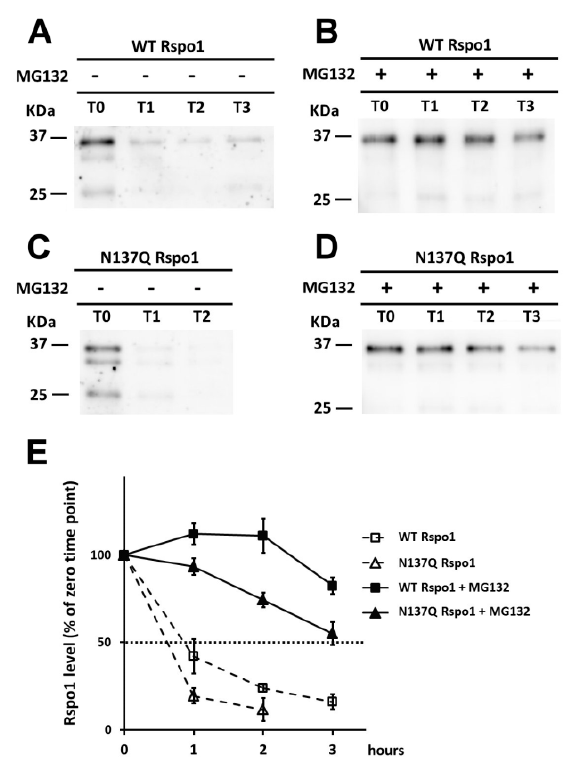
Figure 8. Effect of N-glycan on the stability of intracellular Rspo1. ( A – D ) HEK293T cells were transfected either with WT or N137Q Rspo1. After 24-h post-transfection, cells were labeled with azidohomoalanine and chased at the indicated time points in the presence or absence of MG132. Lysates were collected and conjugated with biotin via click chemistry reaction. Biotinylated proteins were then enriched with streptavidin-agarose and subjected to Western blot analysis using anti-Rspo1. After enhanced chemiluminescence (ECL) development, the same blot was stripped and reprobed with streptavidin-peroxidase for detection of total biotinylated proteins (Figures S1 and S2); ( E ) The densitometric values of Rspo1 were normalized to those of total biotinylated protein for comparison. The intensity of western blot for WT and N137Q Rspo1 at each time point was compared to the level of Rspo1 (100%) at the starting time (0 h). Error bars indicated the SD.